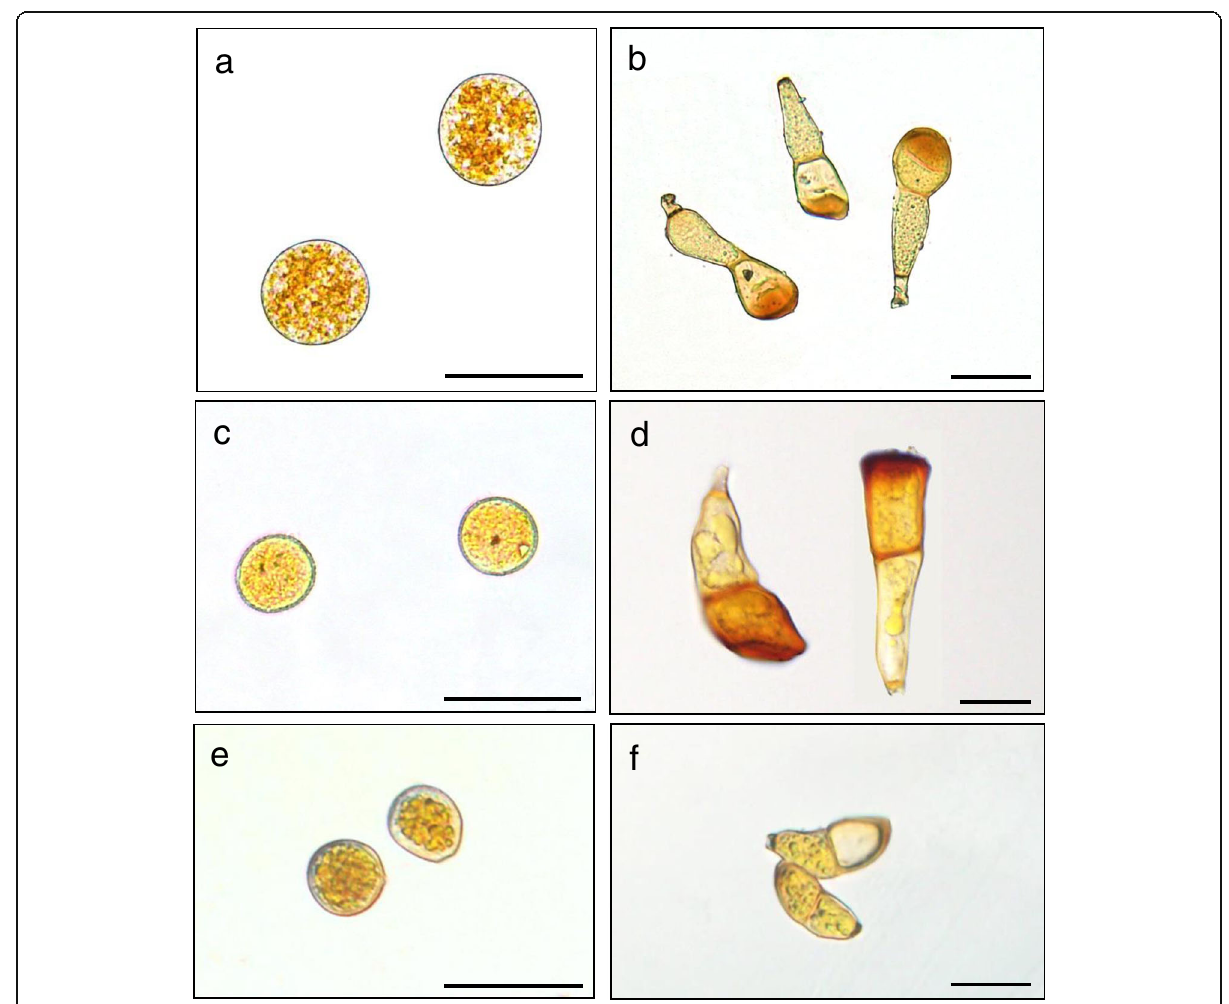
Fig. 2 Urediniospores and teliospores of three formae speciales of Puccinia striiformis . a , b P. striiformis f. sp. agropyri on Agropyron cristatum ; c , d P. striiformis f. sp. elymi on Elymus cylindricus ; e , f P. striiformis f. sp. hordei on barley cv. Guoluo ( Hordeum vulgare var. nudum ). Bar = 50 μ